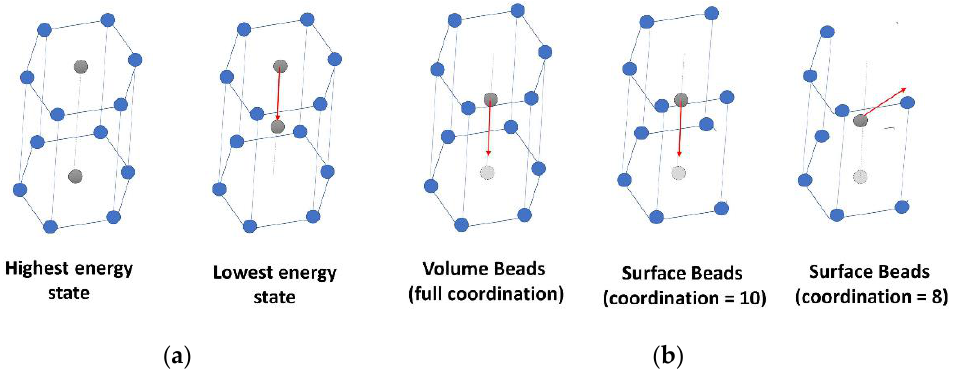
Figure 3. Beads’ displacement paths in the hexagonal collagen structure: ( a ) sliding bead position for lowest and highest energy states; ( b ) displacement paths for the sliding bead for the different coordination configurations.